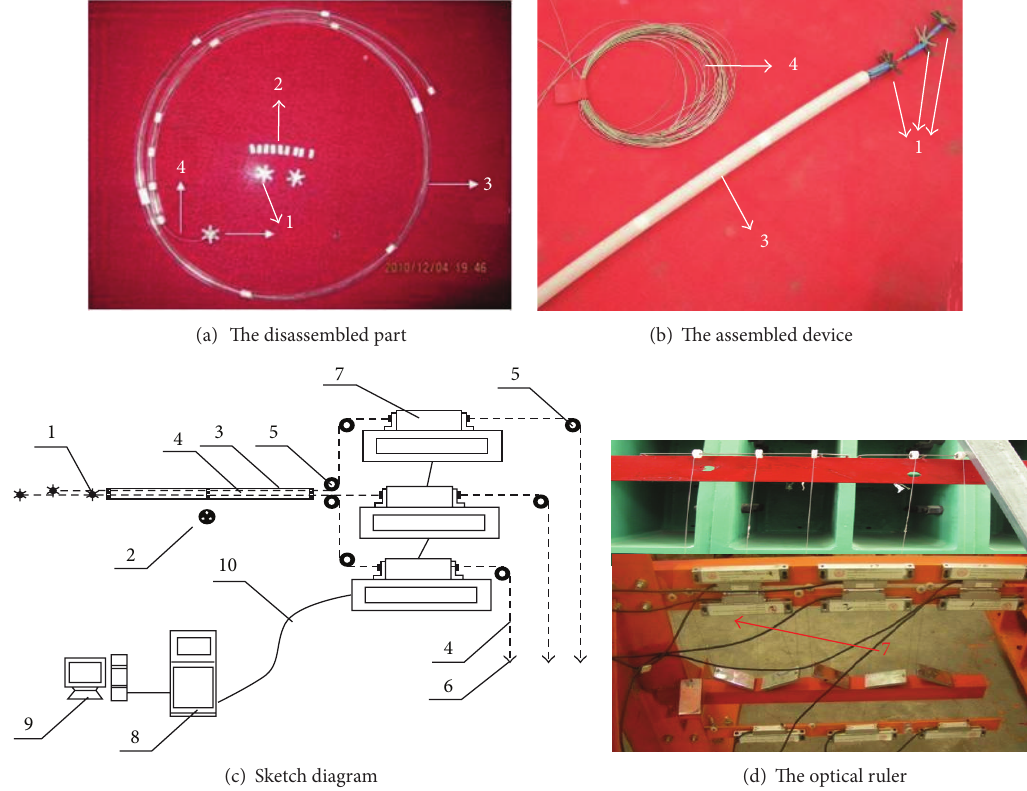
Figure 6: Grating ruler multipoints displacement measuring system (GRDS). (1) Fixed end, (2) guding frame, (3) soft pipe, (4) flexible steel